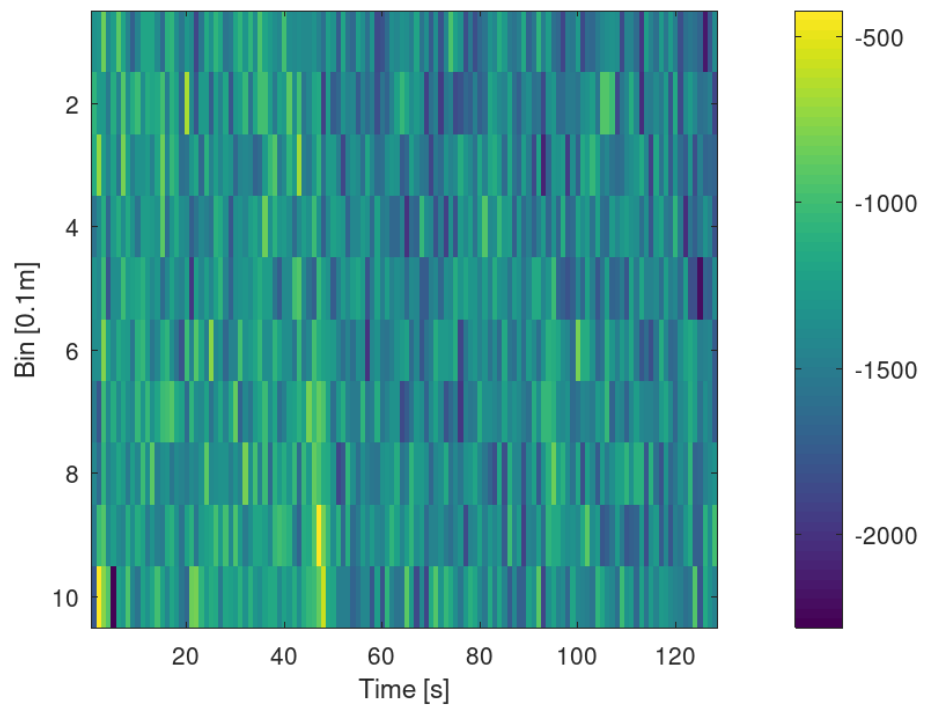
Figure A3. Waterfall plot of inflow x–velocity for Aquadopp1 in mm/s. Bin size is 0.1